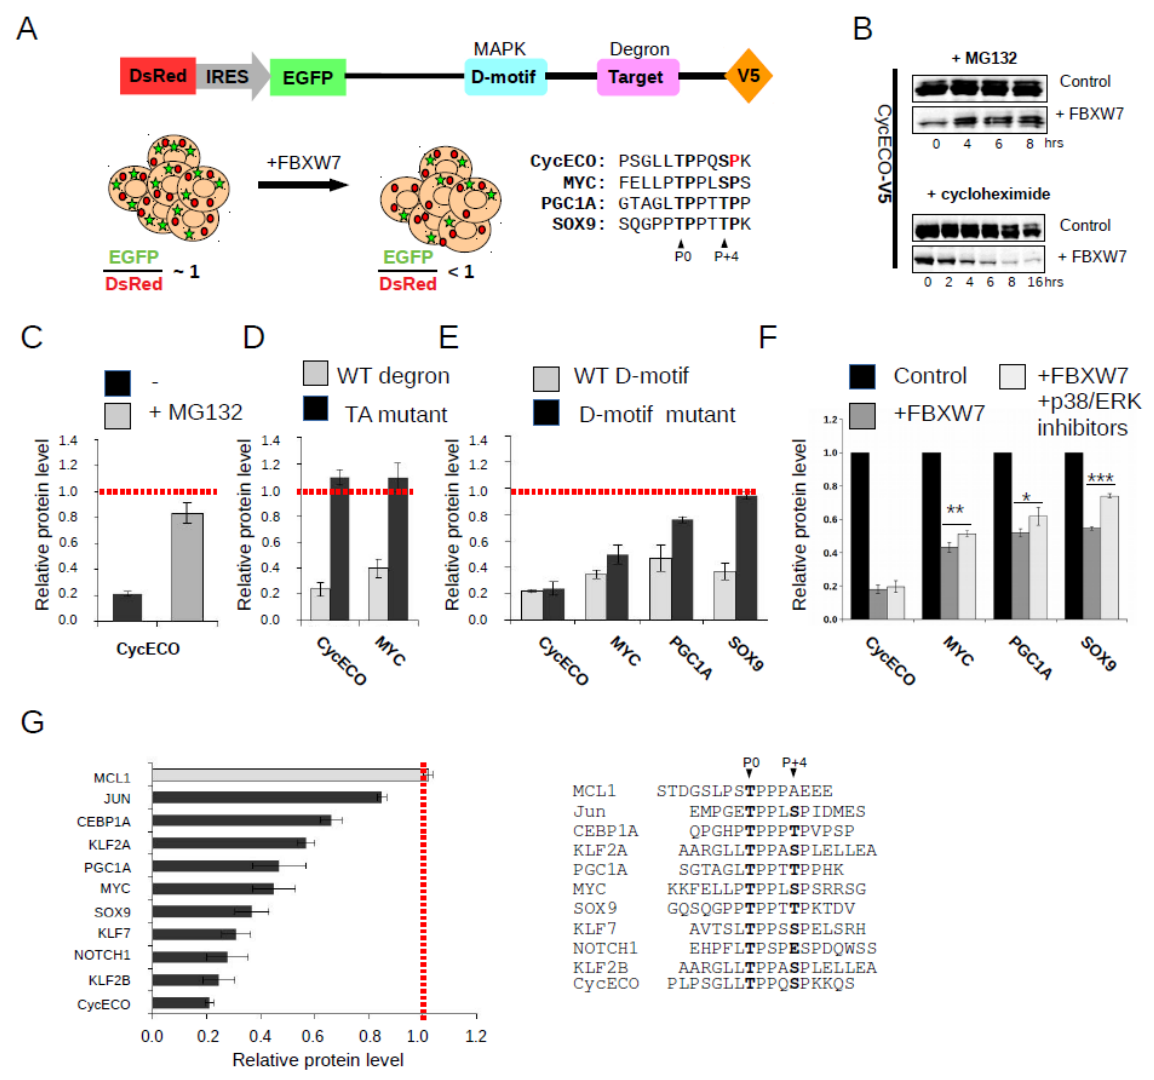
Figure 1. Design and validation of the protein degradation assay used for FBXW7 phosphodegron discovery. ( A ) The assay concept is based on elevated degradation of an EGFP-fused degradation probe upon heterologous FBXW7 expression. The probe contains a MAPK binding D(ocking)-motif (D-motif) to allow selective kinase recruitment and the putative FBXW7 binding phosphodegron (Target). EGFP fluorescence signal is compared to the DsRed signal, and similar expression of DsRed and the EGFP-probe is ensured by the internal ribosome entry site (IRES) between these two gene products. If the phosphodegron motif is functional, the EGFP/DsRed fluorescence signal ratio is expected to drop from 1 to a lower value. The target motifs that were used for the validation of the assay are shown with their kinase phosphorylation target sites (S/TP) highlighted in bold. CycEco (cyclinE C-terminal optimized degron) is a modified motif in which a glycine residue was modified to proline, shown in red, to make it compatible for MAPK-mediated double-phosphory- lation. ( B ) Steady-state CycECO-V5 protein levels after inhibiting the proteosome (+MG132) or